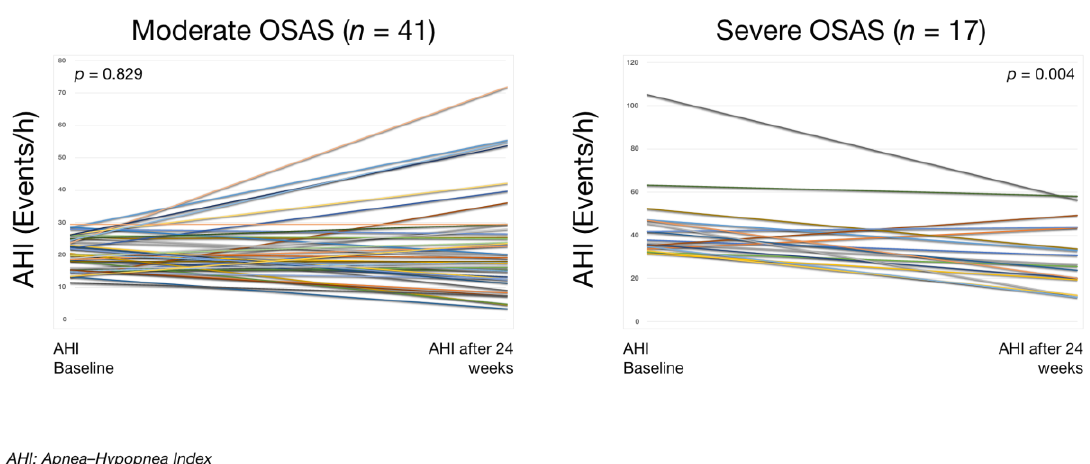
Figure 4. Apnea–hypopnea index before (baseline) and after a physical exercise program (intervention) in patients with moderate vs. severe OSAS. Each line of di ff erent colour represents the individual evolution of AHI for each participant. Within-groups comparison using Wilcoxon’s test for asymmetry distribution. The p -value represents the level of statistical significance of the Student paired t-test for Moderate OSAS and Wilcoxon’s signed-rank test for Severe OSAS.